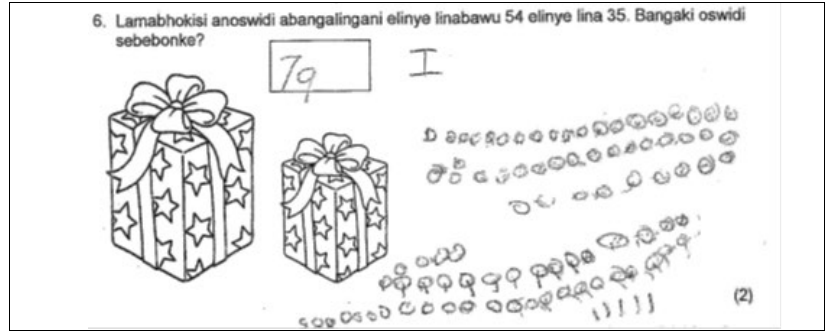
Figure 2: Extract 1 from grade 2 script, learner